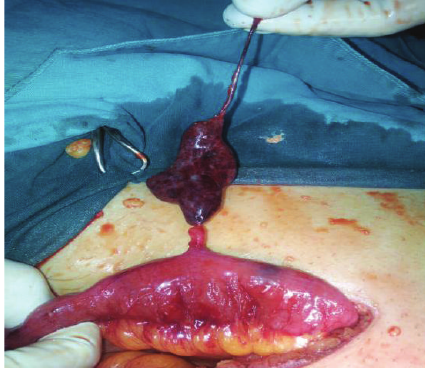
Figure 1: Torsion of Meckel’s diverticulum around the base and necrosis.